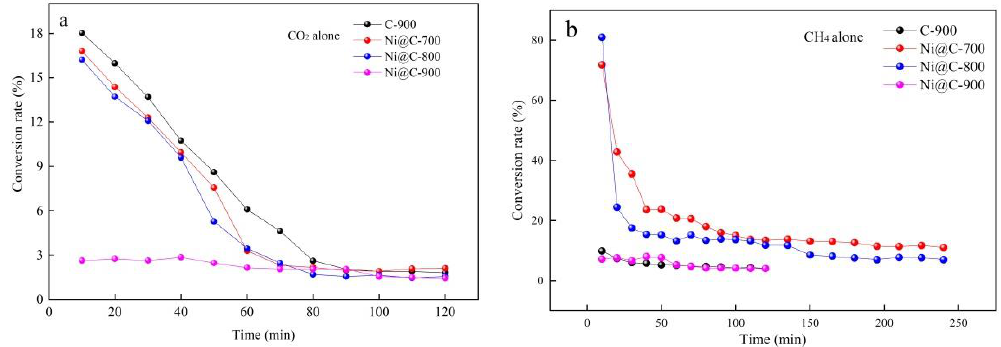
Figure 4. Variation of the ( a ) CO 2 and ( b ) CH 4 conversion over Ni@C-700, Ni@C-800, Ni@C-900, and C-900 (Conditions: 700 °C ; VHSV = 0.17 Lg –1 h –1 ).